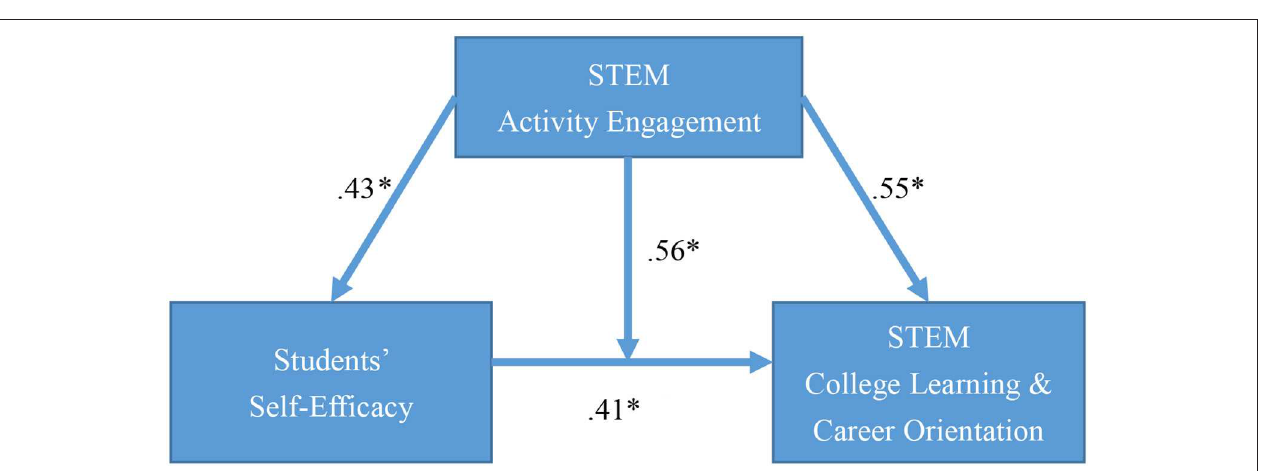
FIGURE 3 | The relationships between Teacher Support, STEM activity engagement, and STEM college learning, and career orientation by using a moderator analysis. * p < 0.05.